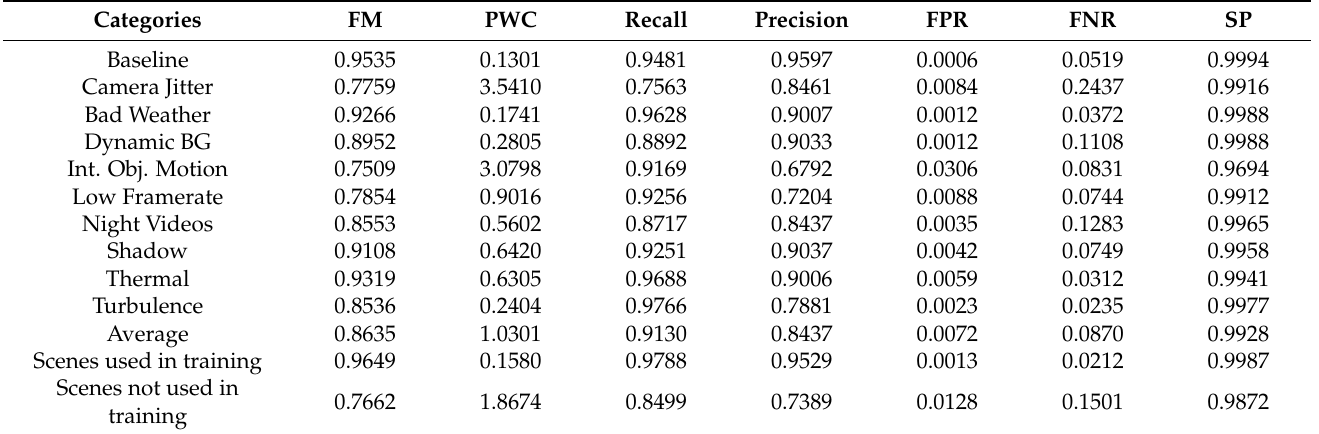
Table 4. Comparison result of FM score by proposed method and other methods on the CDnet 2014 dataset.